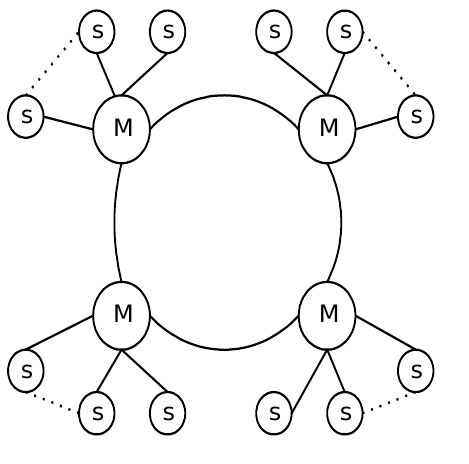
Figure 3.Improved coarse-grained model